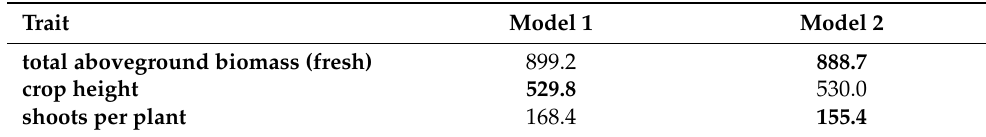
Table 5. Bayesian Information Criteria statistics for Model 1 and 2.